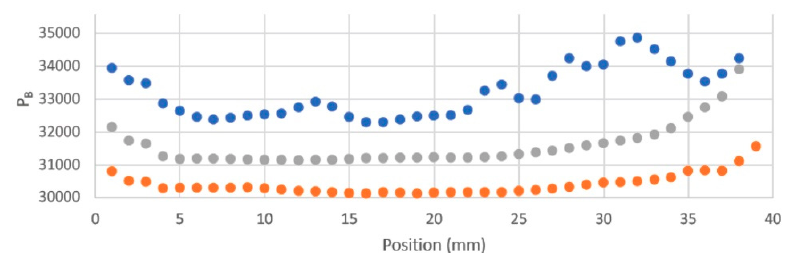
Figure 13. The average blue pixel level in a small area of the DPA solution as a function of the stage position. Upper, blue points: cell cap and slits uncovered; central, grey points: cell cap and shoulder masked; lower, orange points: top of slits masked.